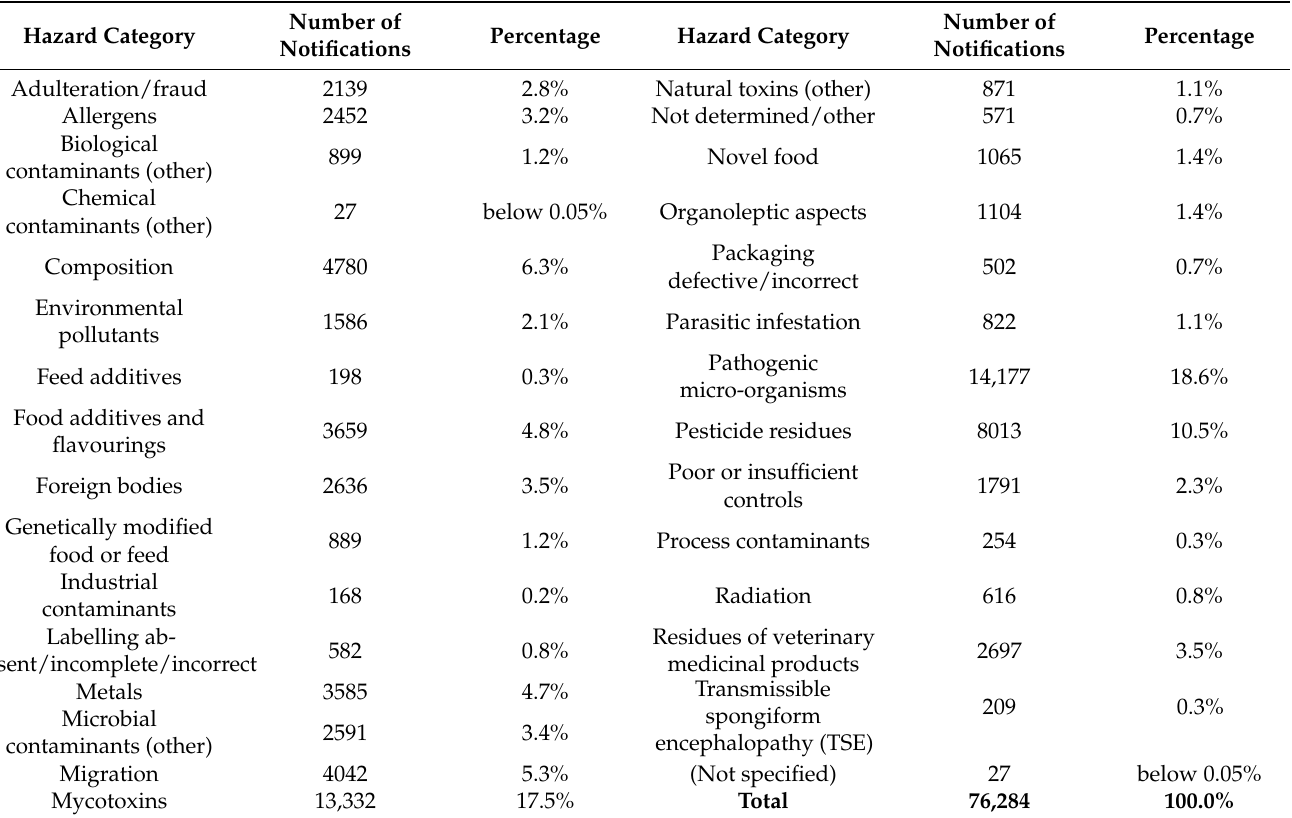
Table 2. Number of notifications and percentage in particular hazard categories in the RASFF in 1981–2020.